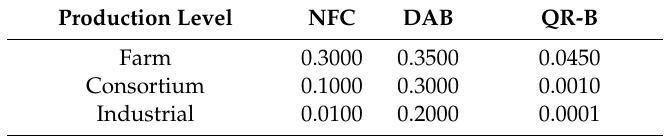
Table 4. Market prices of the di ff erent tags considered for the three production levels (in € unit − 1 ).